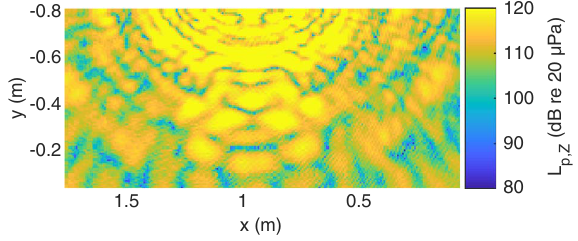
Figure 9. Z -weighted equivalent continuous sound pressure levels time-averaged over 0.64 s L p , Z ,eq 0.64 s of the one-third octave band with a center frequency of 20 kHz in a horizontal plane 24 cm to 99 cm in front of the sonotrode at a height of 1.11 m ( S Figure 9 : z = (cid:1) 1.26 m) with a spatial resolution of 0.6 mm.